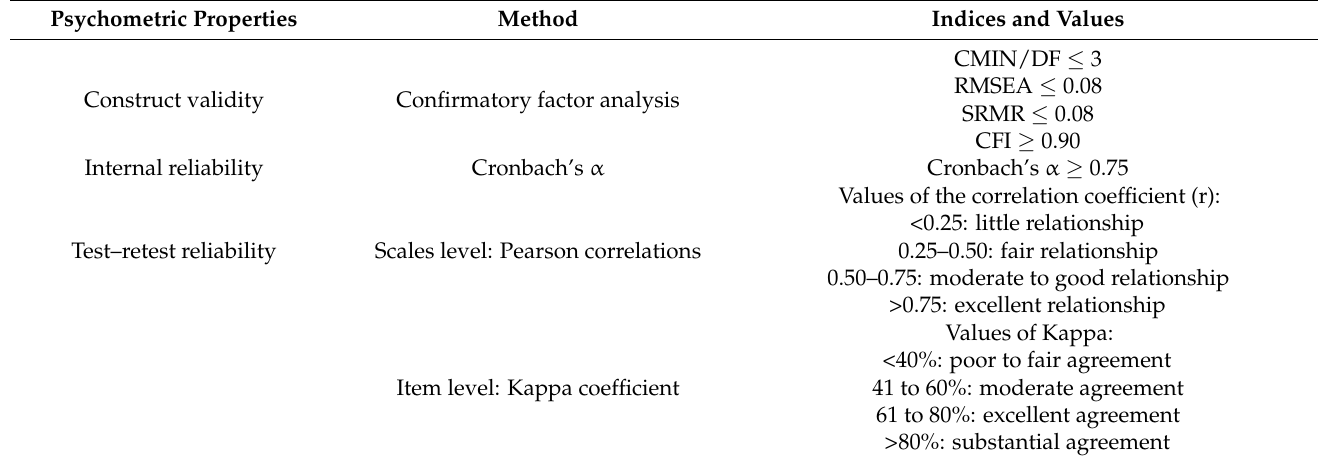
Table 1. Data analysis for psychometric